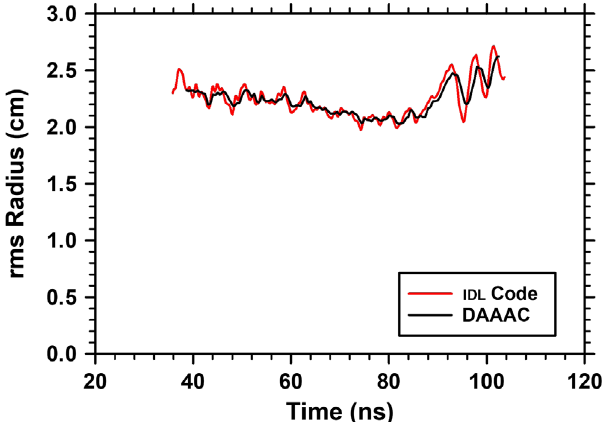
FIG. 9. Comparison between the rms radius calculated by hand using DAAAC (black curve) and our IDL [25] code dml22zeta.pro (red curve) for shot 37858. (Note the expanded time scale).